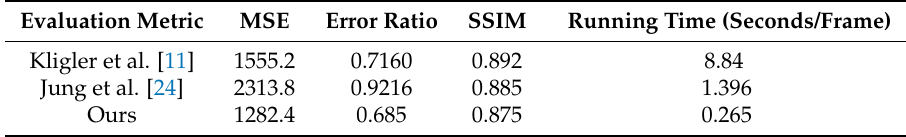
Table 3. Quantitative comparisons of our method and some state-of-the-art approaches for the OSR_CG dataset with three metrics: MSE , Error Ratio , and the average running time on an image with a size of 960 × 544